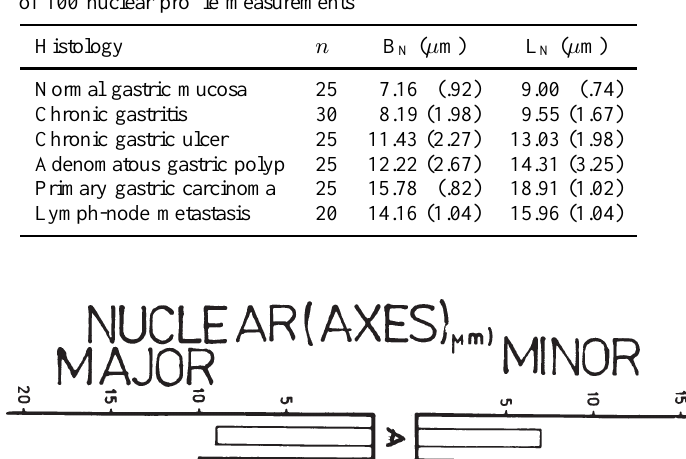
Table 2 Karyometry: B N and L N are, respectively, the minor and major axes of the elliptical nuclear profiles. Means and standard deviations are for n patients. For each patient, the parameter values were the means